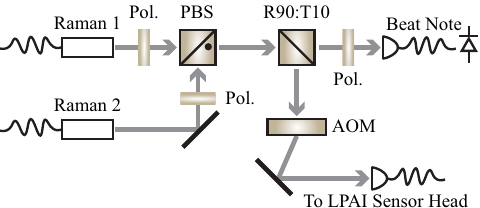
Fig. 10 Optical setup for combining the two 780 nm Raman channels with crossed-linear-polarization and phase locking. Approximately 10% of the combined power is diverted for phase locking while the remaining power is directed towards an acousto-optic modulator for pulsing. The combined Raman beams are coupled into the same polarization maintaining fi ber with the polarizations aligned to the slow and fast axes of the fi ber. PBS polarizing beam splitter, R90:T10, non-polarizing cube beam splitter; Pol. polarizer, AOM acousto-optic